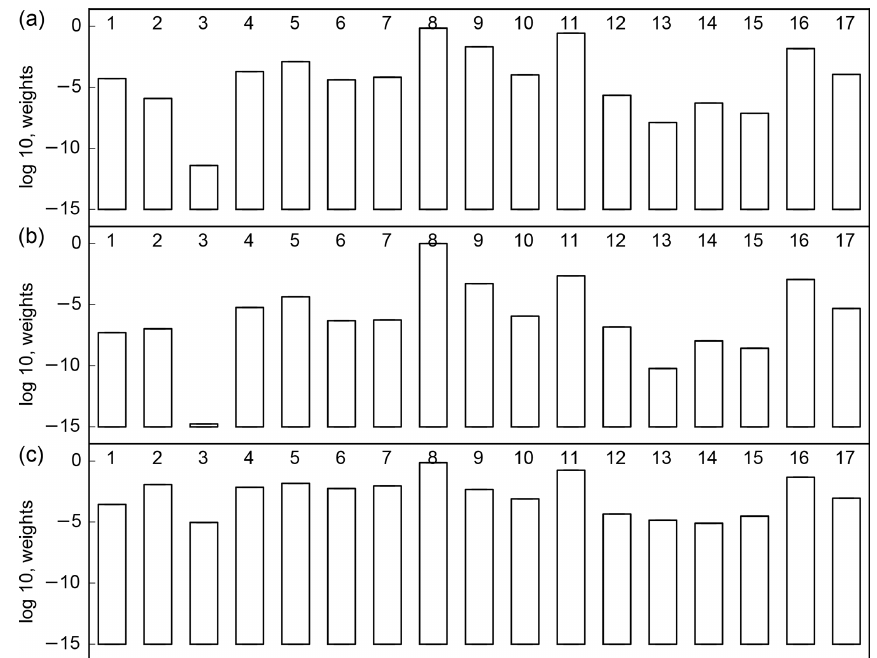
Figure 1. The log 10 of p( H i | y ) for the untuned (a) and tuned (b) cases with residuals used for R (c) TransCom